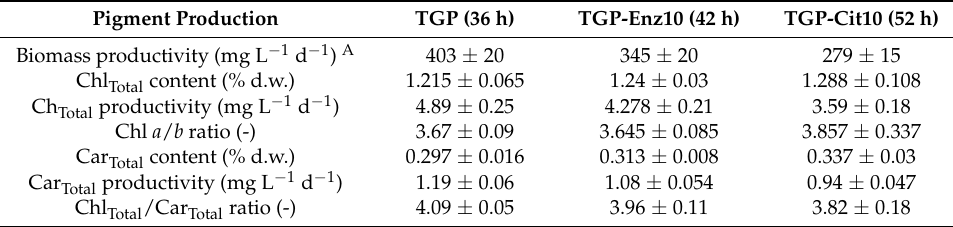
Table 2. Chlorophyll (Ch Total ) content, carotenoid (Car Total ) content and pigment productivity in Chlorella cultures cultivated on 1 g/L glucose (TGP), wood enzymatic 10% hydrolysate containing 1 g/L glucose (TGP-Enz10), and 1 g/L glucose supplemented with 10% neutralized citrate buffer loading (TGP-Cit10). Cultivation conditions: photobioreactor under heterotrophic mode (0 µ E m − 2 s − 1 ) at 25 ◦ C. Number of independent experiments: 3. Pigment